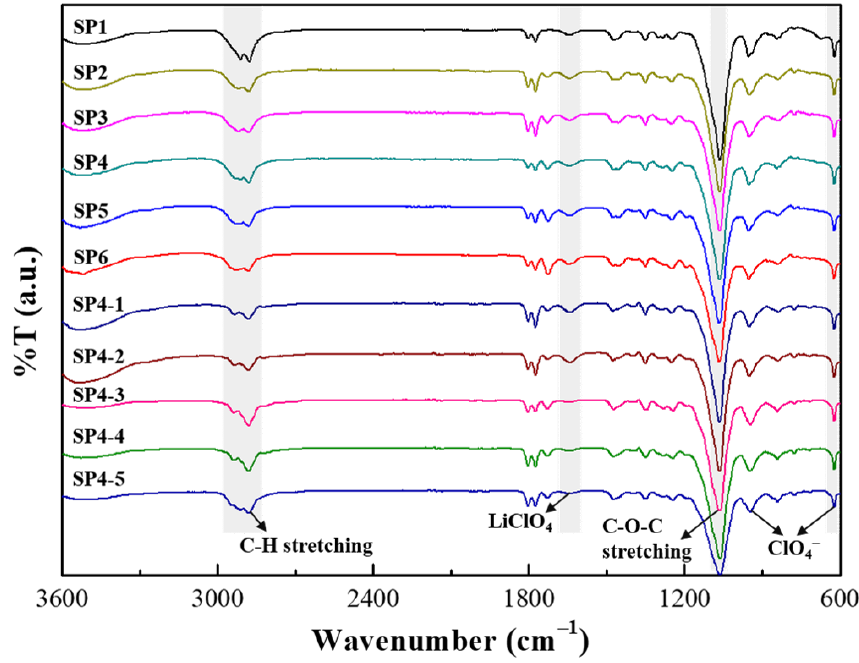
Figure 3. FT-IR spectra of solid polymer electrolyte samples.